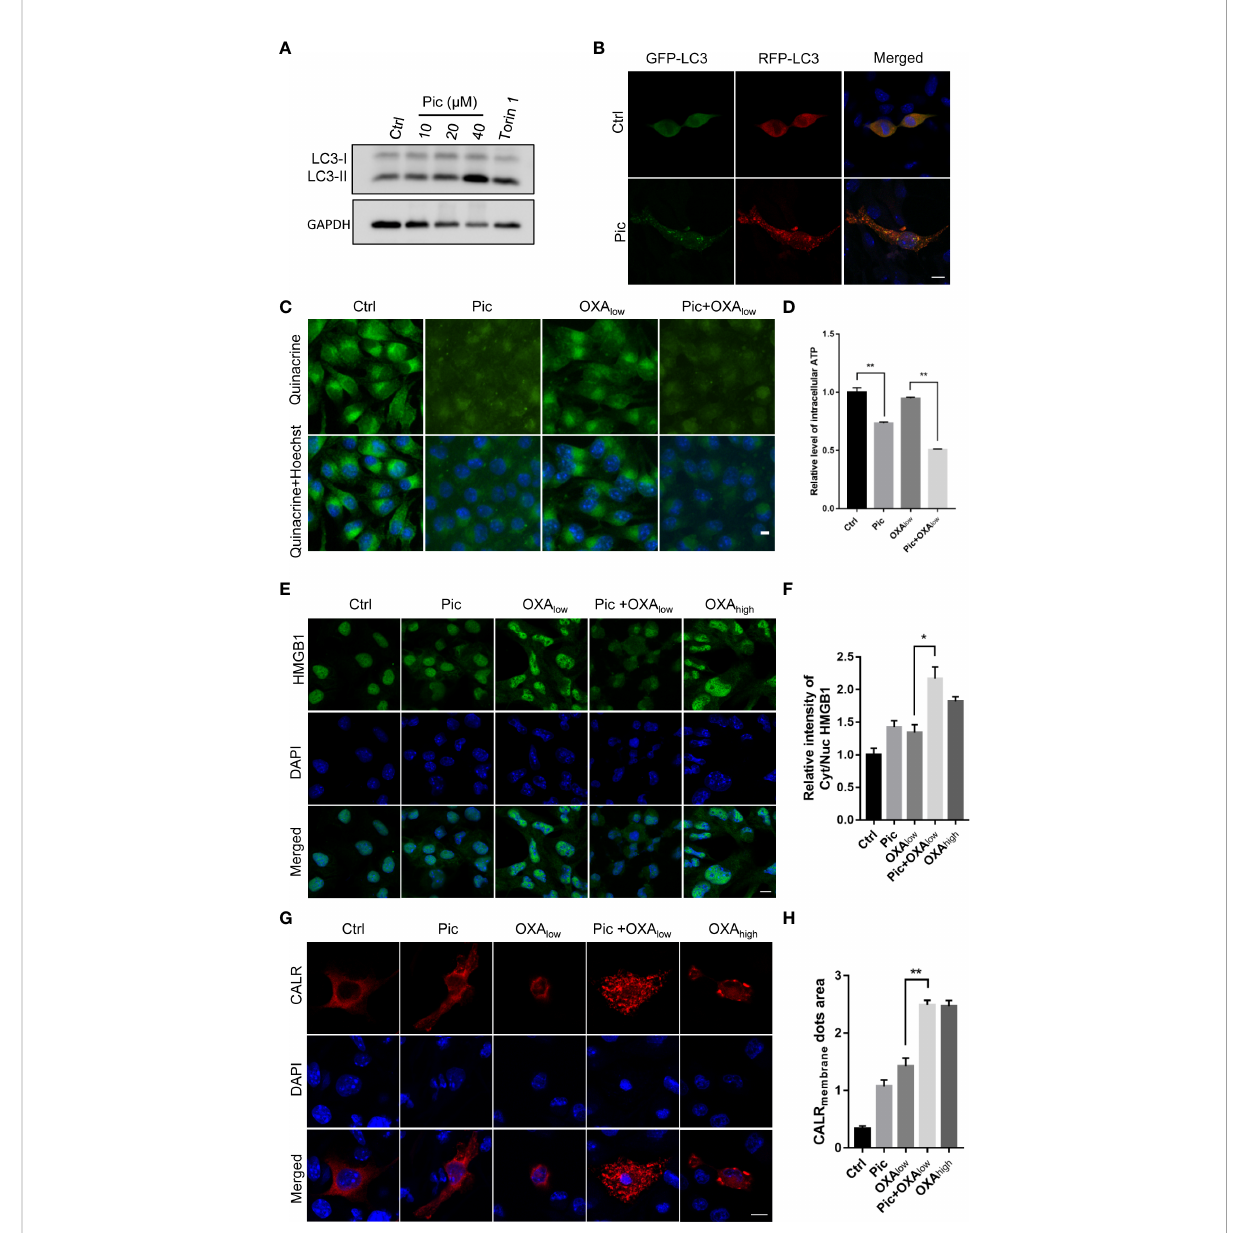
FIGURE 6 Pic increases autophagy and enhances OXA-induced ICD in MCA205 fi brosarcomas. (A) Pic increases LC3-II levels in MCA205 cells. MCA205 cells were treated with different concentrations of Pic (0, 10, 20 and 40 m M) for 24 h before western blotting analysis of LC3-II levels. (B) Pic increases autolysosomes as re fl ected by immunostaining in MCA205 cells expressing tf-LC3. Scale bar: 10 m m. (C, D) Pic (40 m M) reduces the intracellular ATP levels in MCA205 cells with OXA low (200 m M) for 24 h measured by quinacrine staining. Scale bar: 10 m m. (E, F) Pic (40 m M) promotes the release of intracellular HMGB1 in combination with OXA low for 24 h measured by immunostaining. Scale bar: 10 m m. (G, H) Pic (40 m M) promotes cell surface CALR exposure in combination with OXA low for 24 h measured by immunostaining. Scale bar: 10 m m. Data were mean ± SEM of three replicates. Student-t test was used for statistical analysis. * p -value < 0.05, ** p -value <